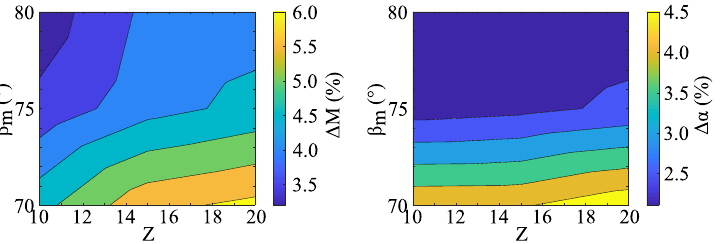
Figure 12. Distribution of non-uniformity index as a function of vane count and outlet metal angle: Mach number and absolute flow